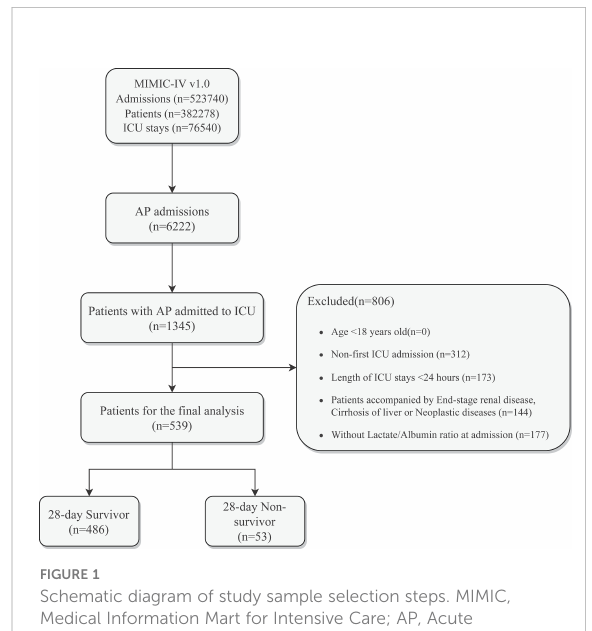
FIGURE 1 Schematic diagram of study sample selection steps. MIMIC, Medical Information Mart for Intensive Care; AP, Acute Pancreatitis; ICU, intensive care unit; LAR, Lactate/Albumin